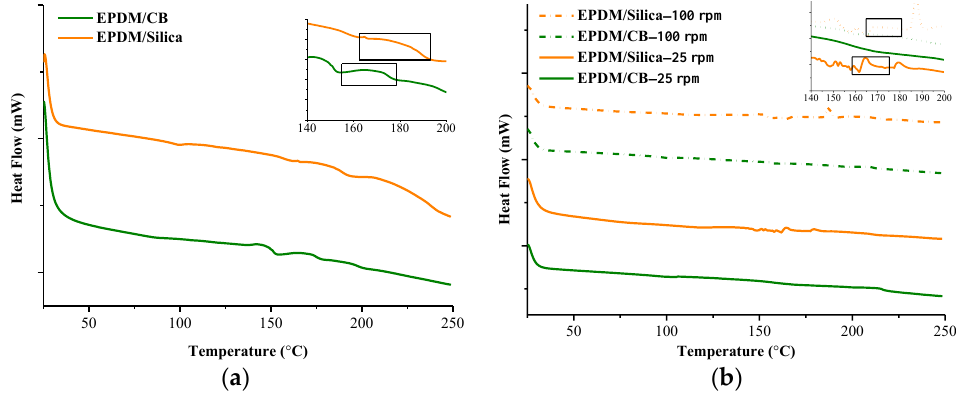
Figure 9. DSC curves of samples ( a ) prepared in Banbury, ( b ) prepared in MC 15 HT. Table 3. DSC results of EPDM/CB and EPDM/Silica composites prepared in Banbury mixer or MC 15 HT.